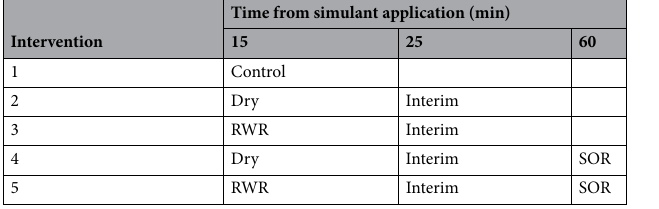
Table 1. Trial design, the design includes 5 conditions: [1] Control, [2] Dry + Interim, [3] RWR + Interim, [4] Dry + Interim + SOR, [5] RWR + Interim + SOR. All participants (n = 11) took part in each stage of the study in random